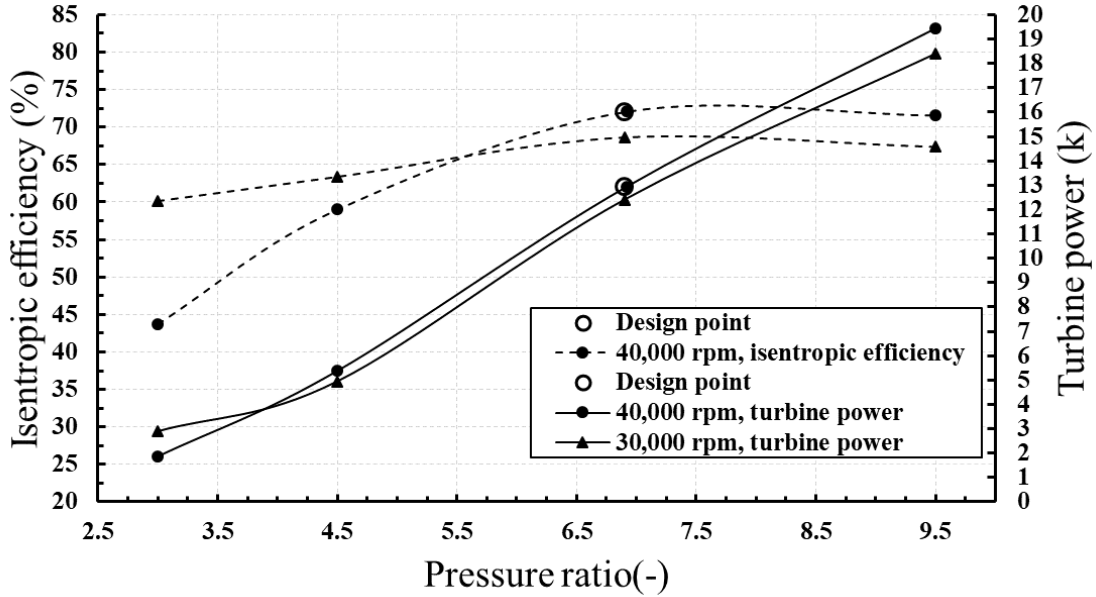
Figure 23. Turbine efficiency and power output at various pressure ratios.